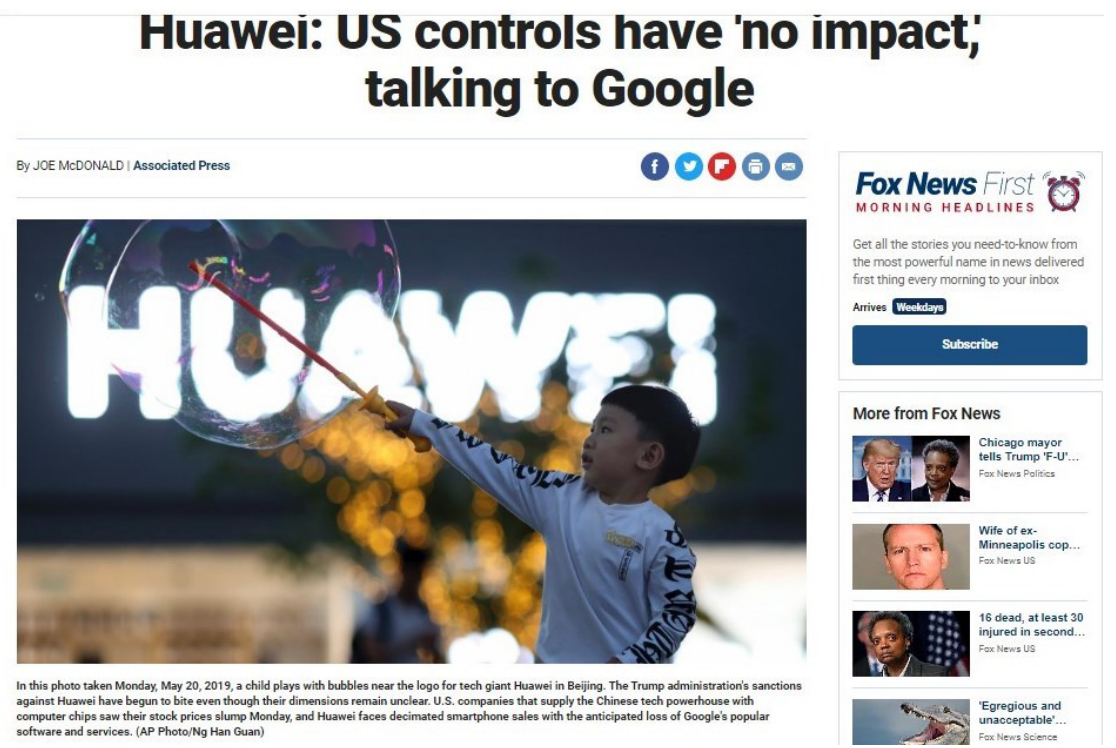
Fig. 1 – A multimodal